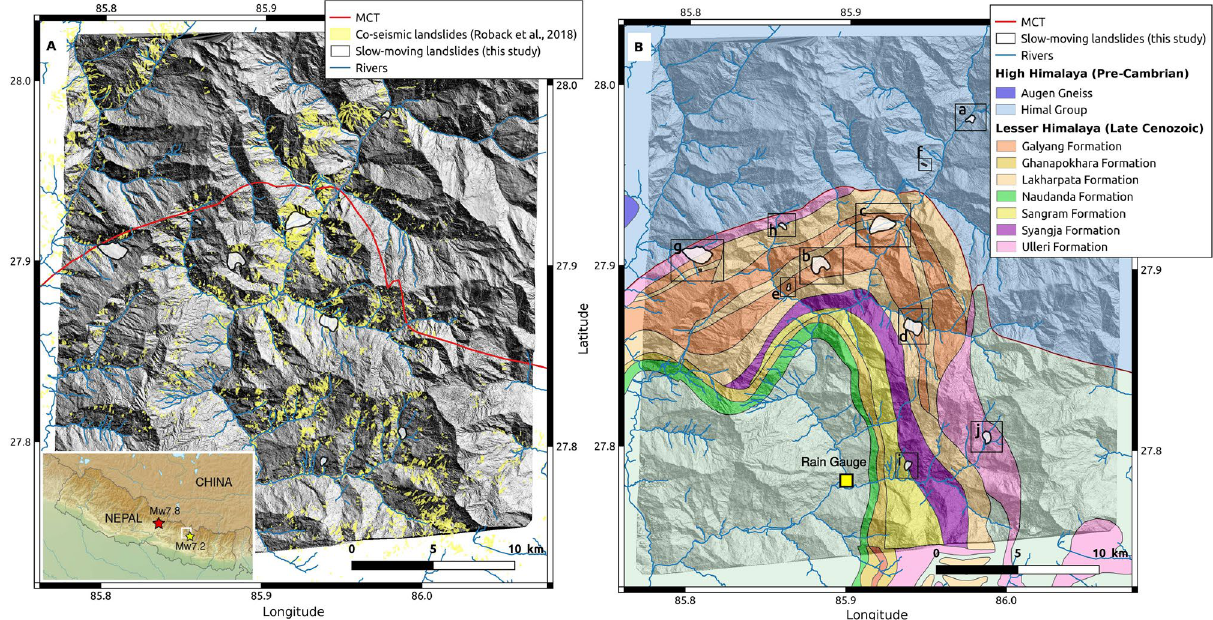
Figure 2. Topographic ( A ) and geological map ( B ) of the site study in Nepal. The hillshade topography is the DEM produced using Ames Stereo Pipeline v2.5.3 on the Pléiades stereo acquisitions from December 2015 (see “Methods”). The white shapes with black contours correspond to the slow-moving landslides detected in this study. The Main Central Thrust (MCT) is represented with a thick red line. On panel ( A ) the co-seismic landslide inventory is based on 21 . On panel ( B ), the black frames correspond to the zooms around the slow- moving landslides shown in the Supplementary materials (noted from a to j). The geological map is based on 1/250000 quadrangle maps of the Department of Mines and Geology. The inset shows the locations of the main shock of April 25 2015 and its aftershock of Mw 7.3 on 12 May 2015, close by the area of study. The rain gauge of Bahrabise is shown with a yellow square. QGIS 23 was used to create this